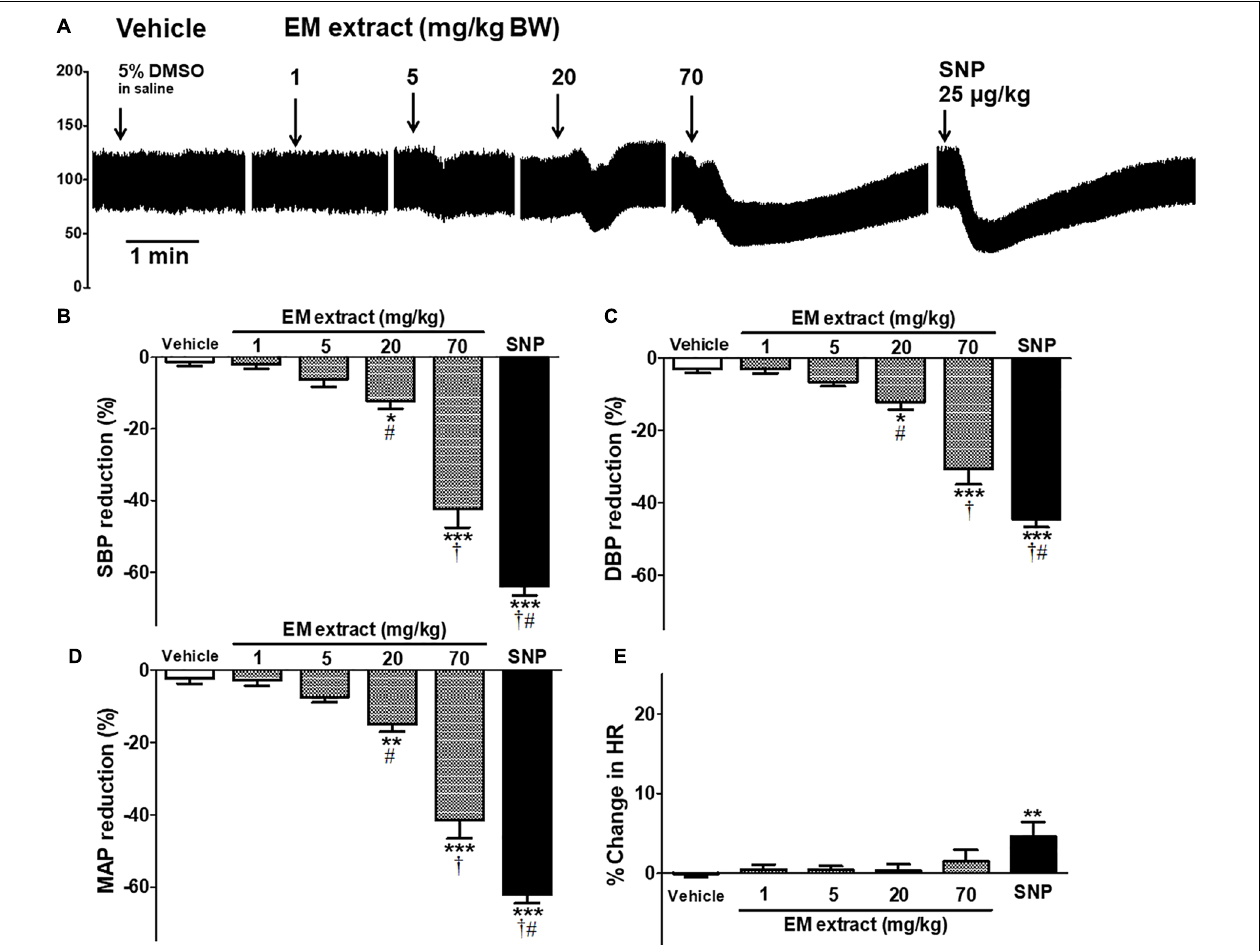
FIGURE 7 | Acute effect of EM extract on blood pressure in normotensive anesthetized rats. (A) blood pressure traces showing the effect of single intravenous injections of vehicle (5% DMSO in saline), EM extract (1, 5, 20, 70 mg/kg BW and SNP 25 µ g/kg BW, over 20 s). The bars show the percentage reduction in systolic (B) , diastolic (C) , mean arterial blood pressure (D) and the percent change in heart rate (E) , calculated from the values measured at the peak effect of DMSO, EM extract, and SNP at the doses indicated, as compared to the baseline value before each infusion. Data are expressed as means ± SEM of n animals. ∗ p < 0.05, ∗∗ p < 0.01, ∗∗∗ p < 0.001 vs. vehicle, † p < 0.001 vs. EM extract 20 mg/kg, # p < 0.001 vs. EM extract 70 mg/kg, ( n =